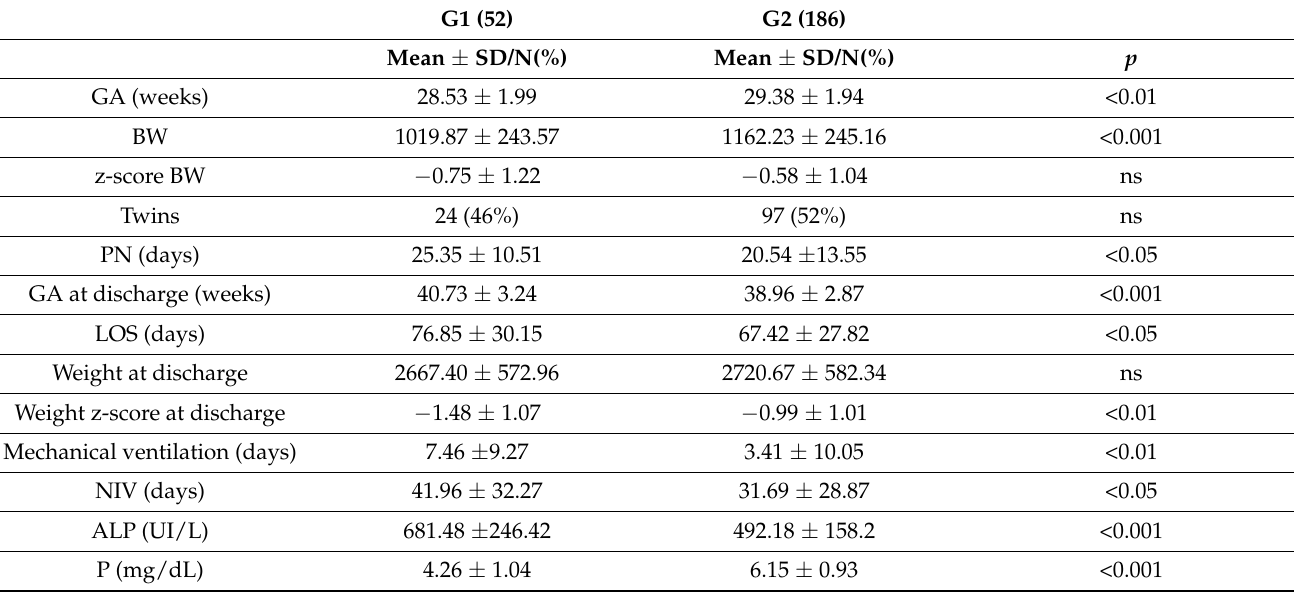
Table 1. Clinical data. GA, gestational age; BW, birth weight; PN, parenteral nutrition; LOS, length of stay; NIV, noninvasive ventilation; ALP, alkaline phosphatase; P, phosphorus. G1, subjects at increased risk of metabolic bone disease. G2, subjects with standard risk of metabolic bone disease.